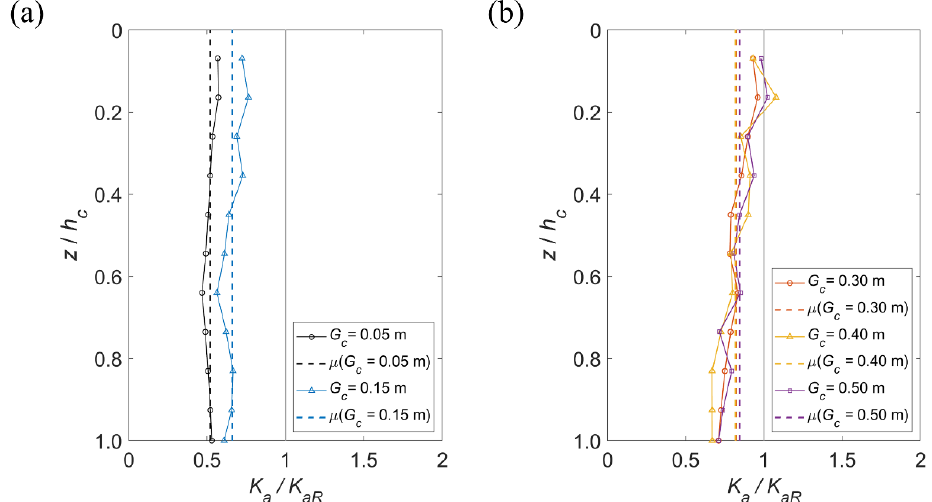
Figure 9. Vertical profiles of the normalized pressures when ( a ) 𝐺 (cid:3030) < 𝐺 (cid:3030)(cid:3019) and ( b ) 𝐺 (cid:3030) ≥ 𝐺 (cid:3030)(cid:3019) . In Figure 10, the vertical profiles of 𝐾 (cid:3028) /𝐾 (cid:3028)(cid:3019) are presented, illustrating the relative magnitude the normalized earth pressure with respect to Rankine’s coefficient. In the figure, the depth-averaged value of 𝐾 (cid:3028) /𝐾 (cid:3028)(cid:3019) for each 𝐺 (cid:3030) condition is also shown as a dot- ted line. As shown in Figure 10a, the values of 𝐾 (cid:3028) /𝐾 (cid:3028)(cid:3019) did not change significantly in the